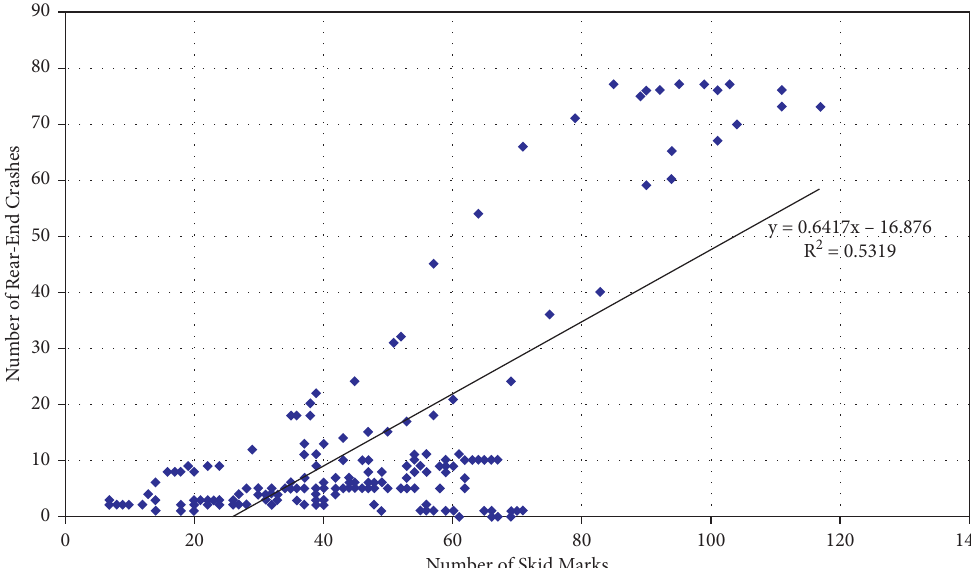
Figure 12: Sliding windows rear-end crash vs. skid correlation on Interstate 80 eastbound (1.0-mile windows, 0.05-mile step).